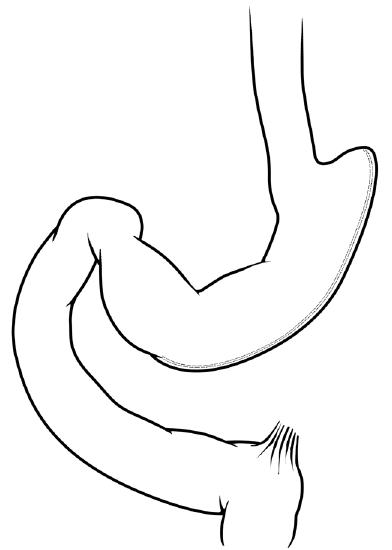
Figure 1. Vertical sleeve gastrectomy. A majority of the greater curvature of the stomach is excised in this operation, creating a tube-like stomach with a marked reduction in gastric capacity. Reprinted with permission 35